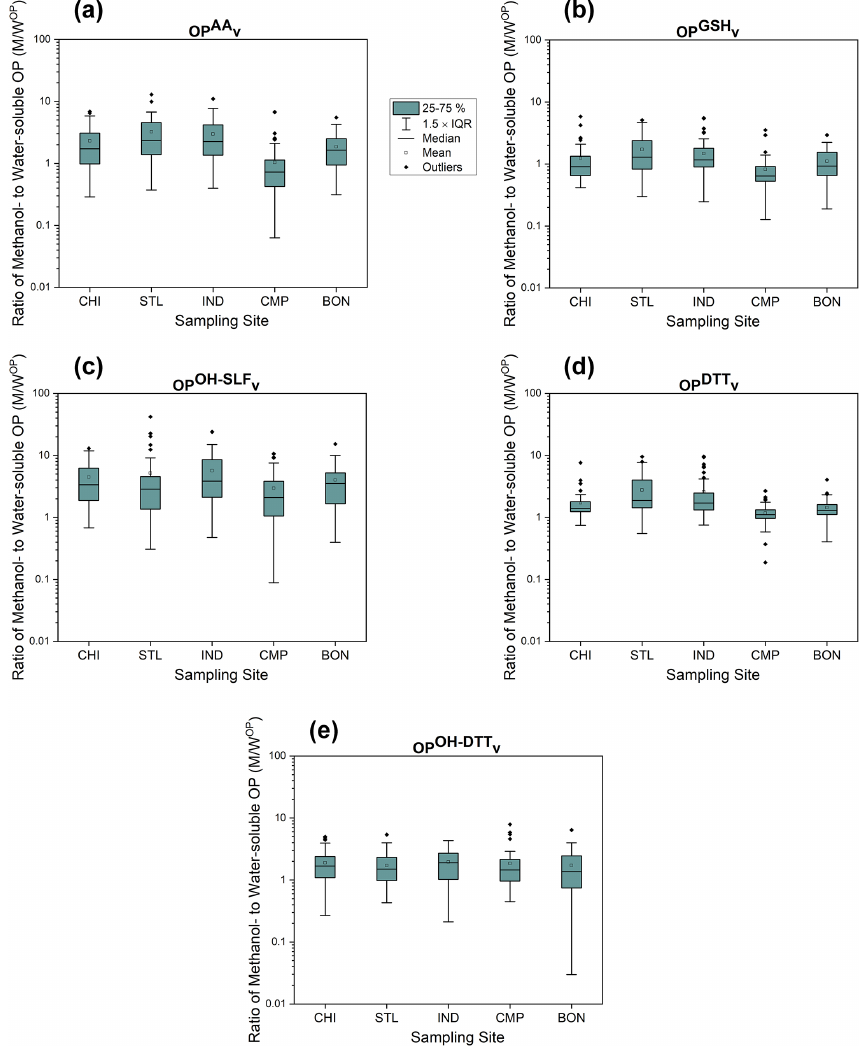
Figure 7. Ratio of methanol-soluble OPv to water-soluble OPv (M / W OP ) for (a) OP AA v, (b) OP GSH v, (c) OP OH − SLF v, (d) OP DTT v, and (e) OP OH − DTT v at five sampling